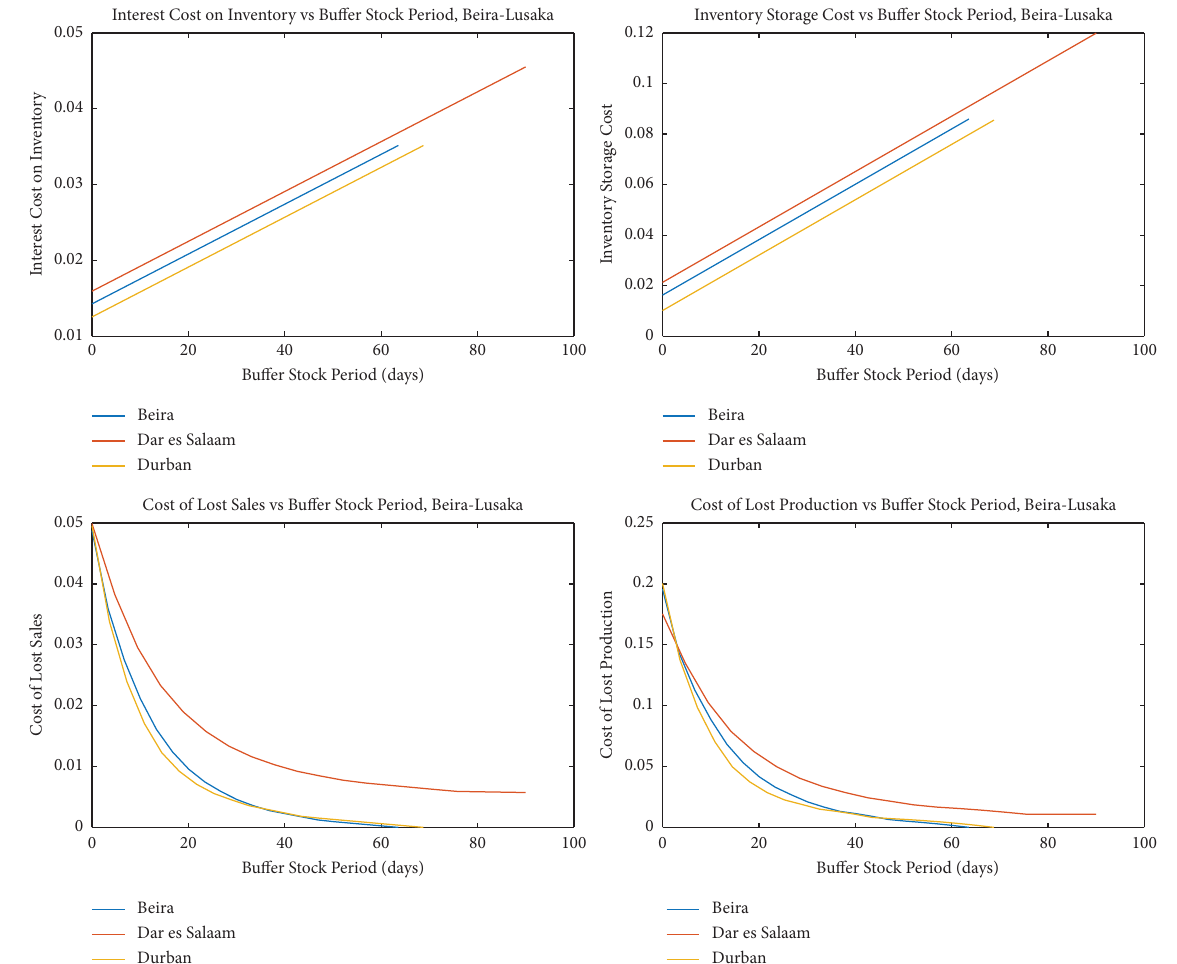
Figure 4: Contributors to cost resulting from time delay variability for three corridors to Lusaka: Beira, Dar es Salaam, and Durban. Te graphs on the left are for retail and on the right for